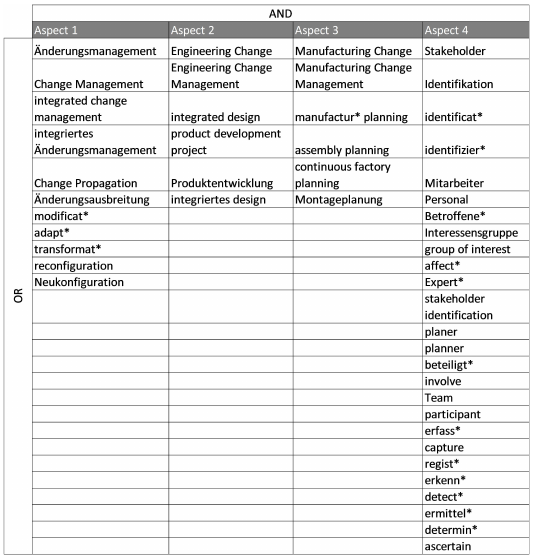
Figure A1. Search terms of the literature analysis. * represents any possible word endings